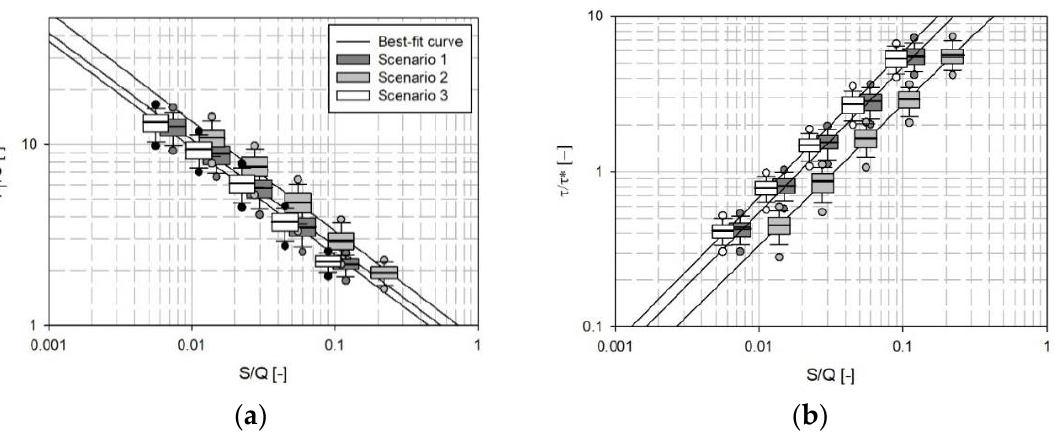
Figure 5. Box-and-whisker plots of the annual variability of the usage volume per unit of tank capacity (U = Y T / S , panel ( a )) and normalized detention time ( τ / τ * , panel ( b )) as a function of the storage fraction ( S / Q ) in the three investigated scenarios. The box-and-whisker description is the same as that in Figure 1. Continuous lines represent the power law regression function calculated from the annual mean values. Table 3. Coefficients ( α and β ) and Pearson coefficient ( R 2 ) of the power law regression function for the usage volume per unit of tank capacity and the normalized detention time in each collection scenario. Y T /S τ / τ